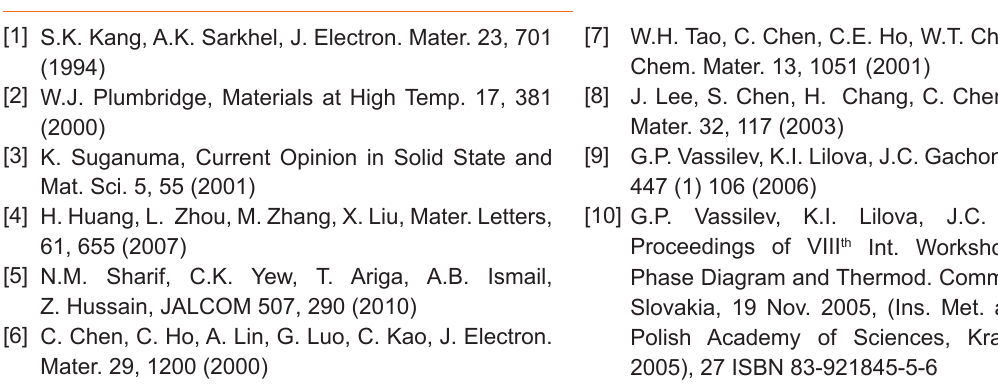
Fig. 4, T=1500 K, Bi/Sn ratio equal to 25/1).